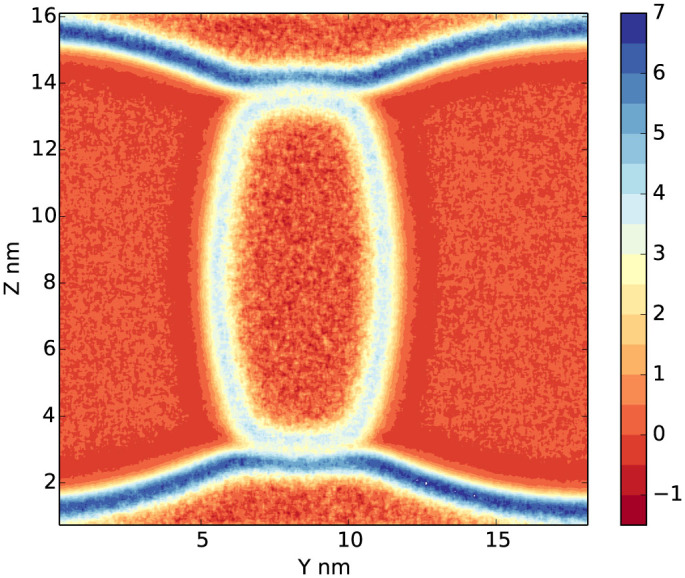
Spatial distribution of Pyy(r) + Pzz(r) − 2Pxx(r) in gas/liquid1/liquid2 model.It approximately gives the total excess free energy distribution due to the multiple-phase coexistence. The unit of stress in the figure is pyy + pzz − 2pxx ≈ 22.3 bar.